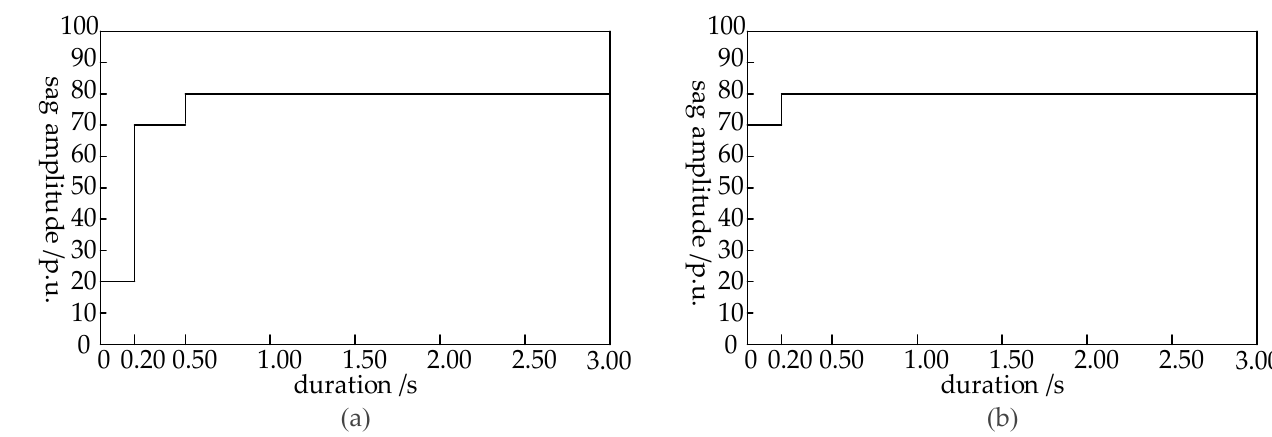
Figure 5. Voltage sag tolerance curve of equipment to sag type I/II/III: ( a ) sag type I/II; ( b ) sag type III.